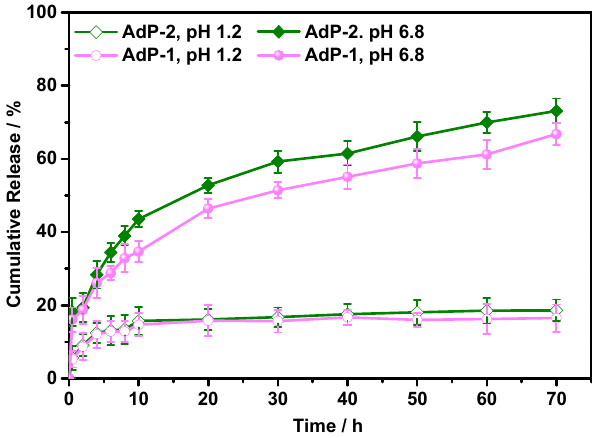
Figure 7. In vitro release profiles of PTX-loaded micelles. Table 3. In vitro release kinetics equation simulation of the